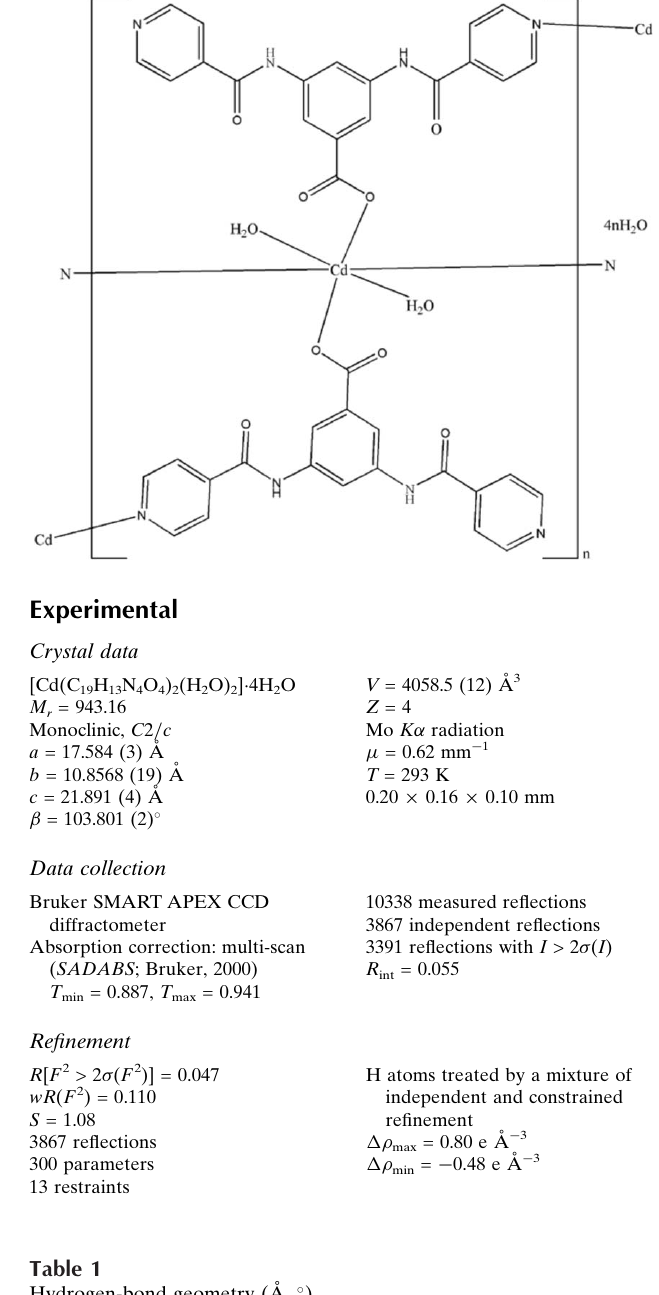
Hydrogen-bond geometry (A˚ , (cid:3) ). D —H (cid:2)(cid:2)(cid:2)